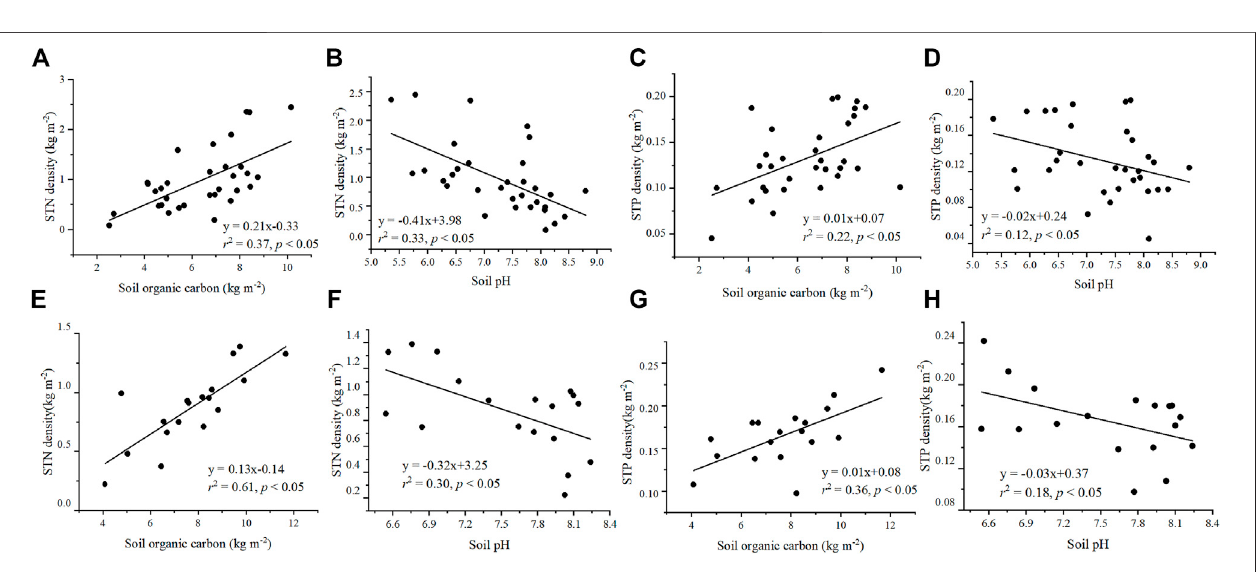
Frontiers in Environmental Science |